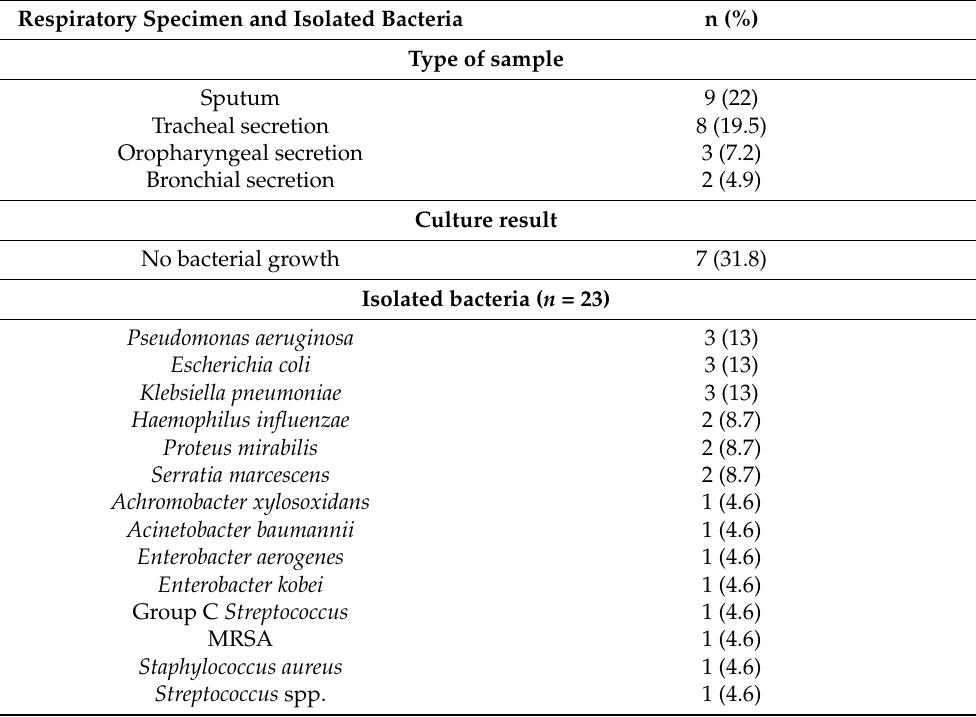
Table 2. Respiratory specimen and isolated bacteria (n =